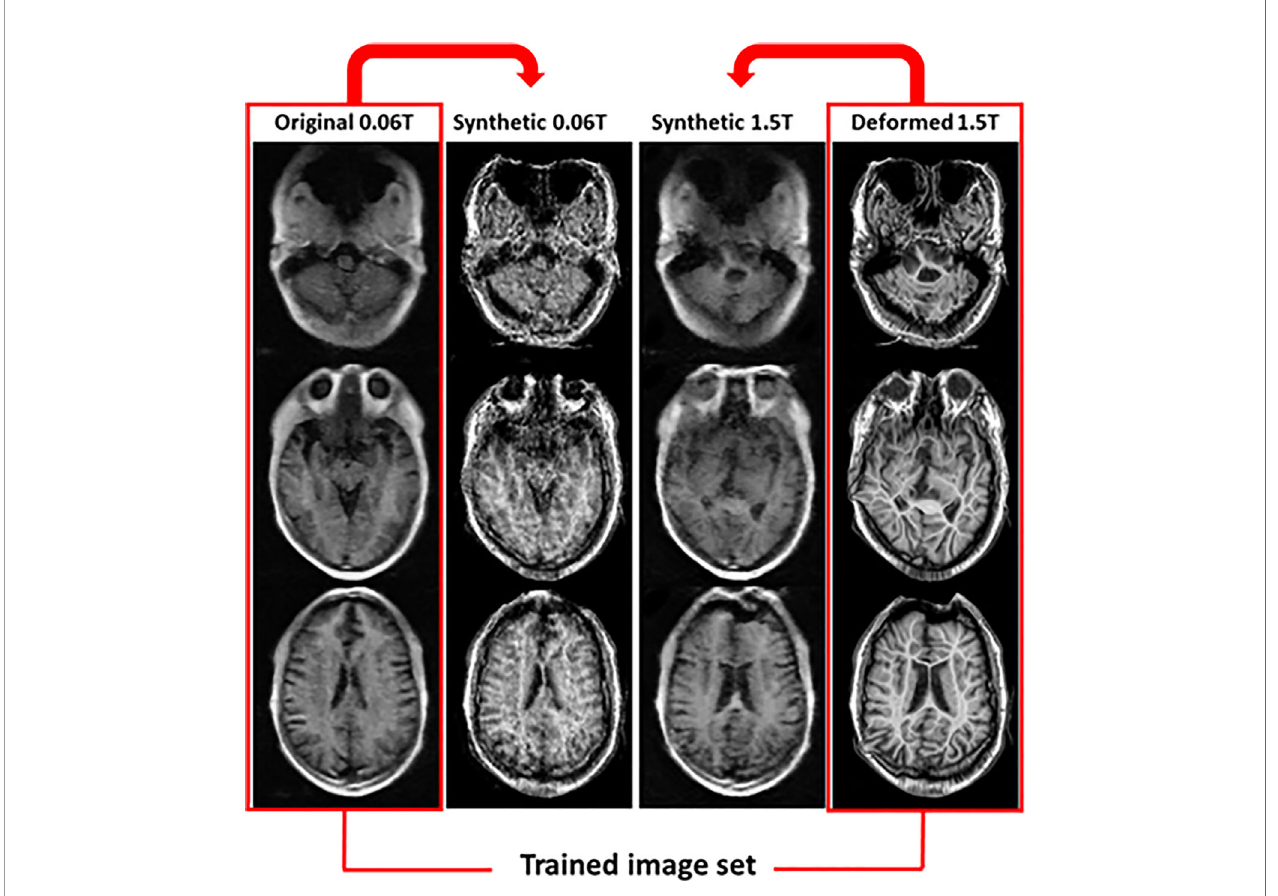
FIGURE 5 | Synthetic MR images from original 0.06 Tesla and deformed 1.5 Tesla MR images in step 2 (cyclic-GAN model, method